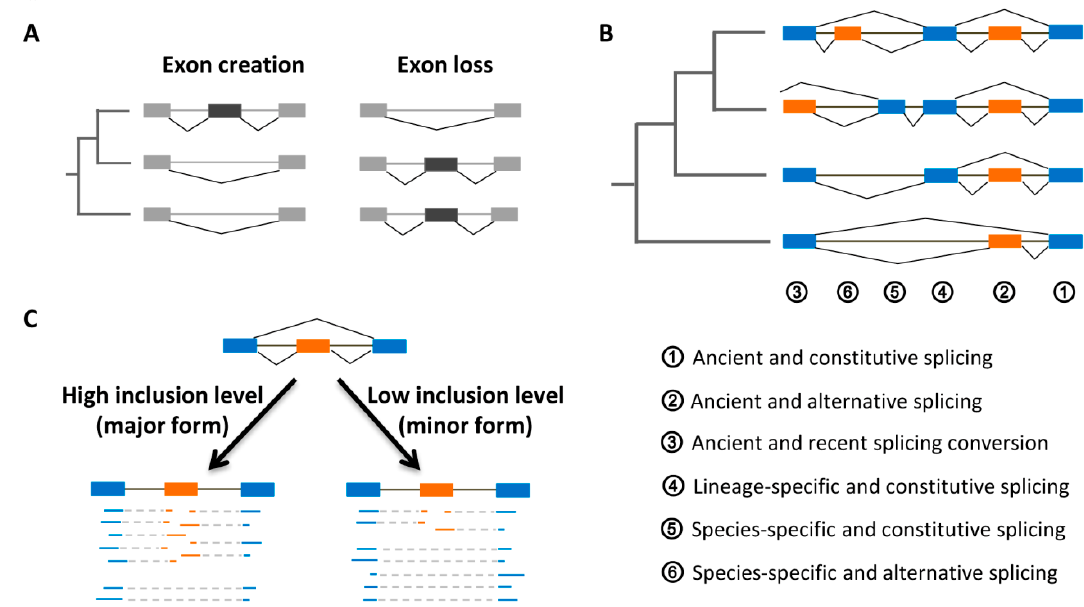
Figure 3. Exon evolutionary ages and inclusion levels. ( A ) Exon creation as well as loss is first illustrated within an evolutionary tree of three species. Subsequently, six exons are schematically exemplified to show the different evolutionary ages and splicing patterns ( B ). The inclusion levels of one alternative exon are detected by the spliced mapping of RNA-Seq reads against reference genome ( C ).